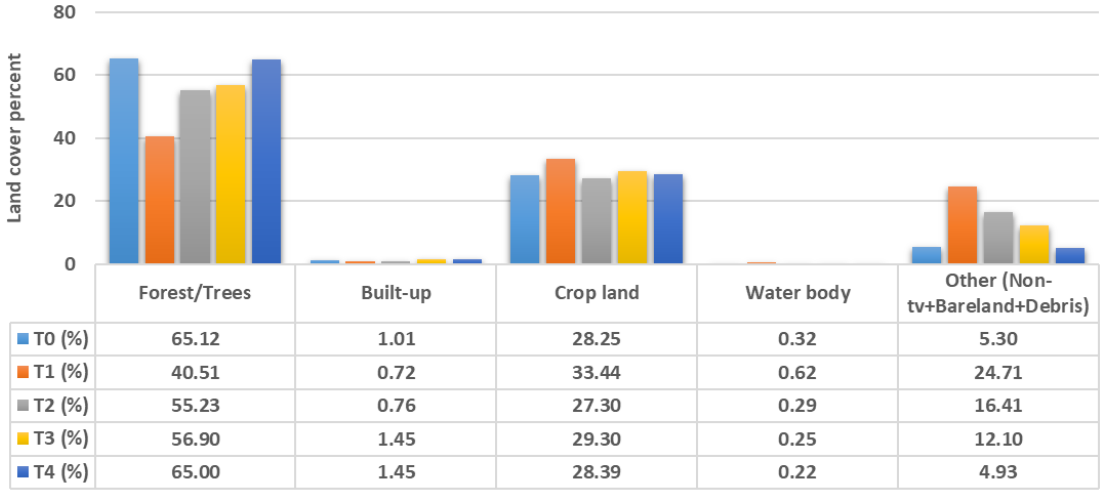
Figure 4. Per class land cover percentage for Leyte island for T0–T4. Non-tv—Non-tree vegetation.